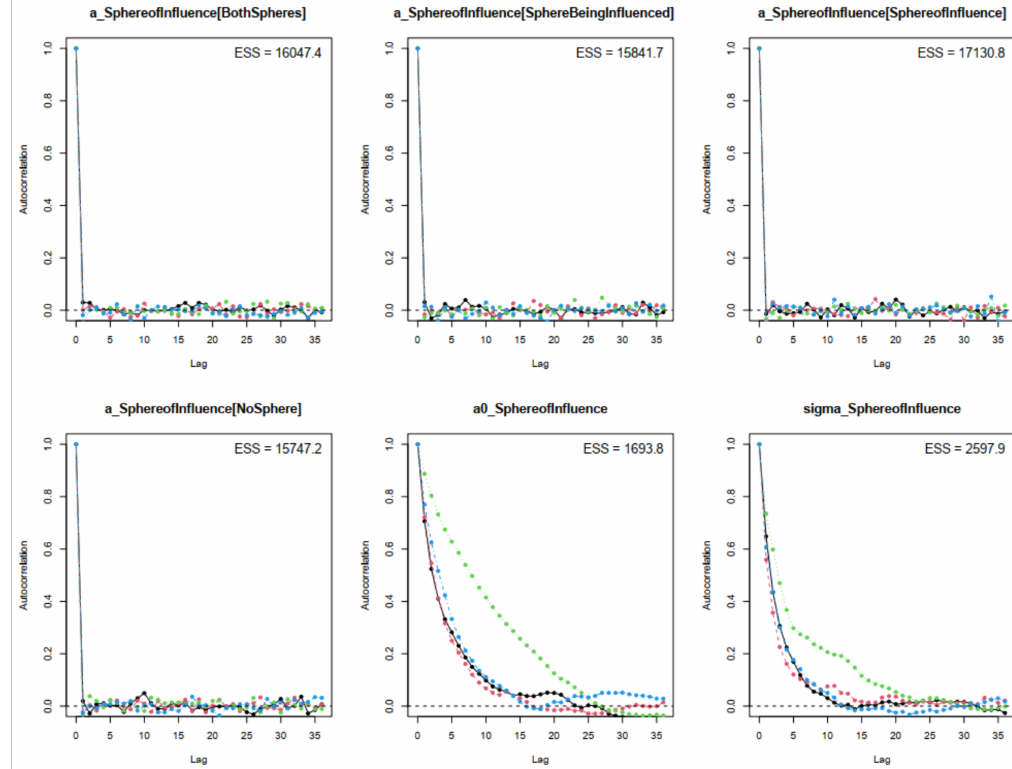
Figure A6. Model 2 (cid:48) autocorrelation plots.